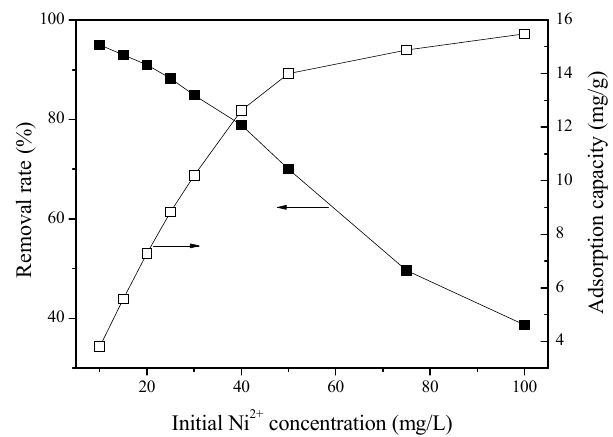
Figure 9. Effect of initial Ni 2+ concentration on the adsorption of Ni 2+ by synthesized zeolite (pH 5, contact time 30 min, adsorbent dose 2.5 g/L).